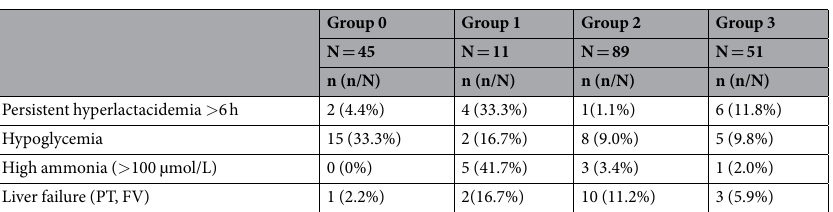
Table 4. Laboratory parameters data in the 196 neonates for whom metabolic testings were performed. Group 0: neonates with a final diagnosis of transient disorder; group 1: neonates diagnosed with IMD confirmed by molecular testing; group 2: neonates suffering from a non-metabolic disease; group 3: neonates with chronic clinical abnormalities but for whom no diagnosis could be